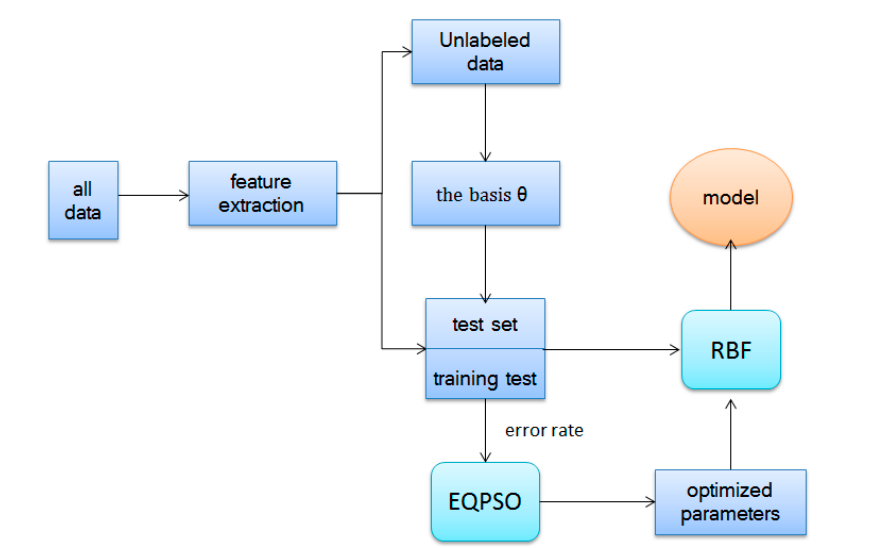
Figure 6. Flow chart of self-taught learning.